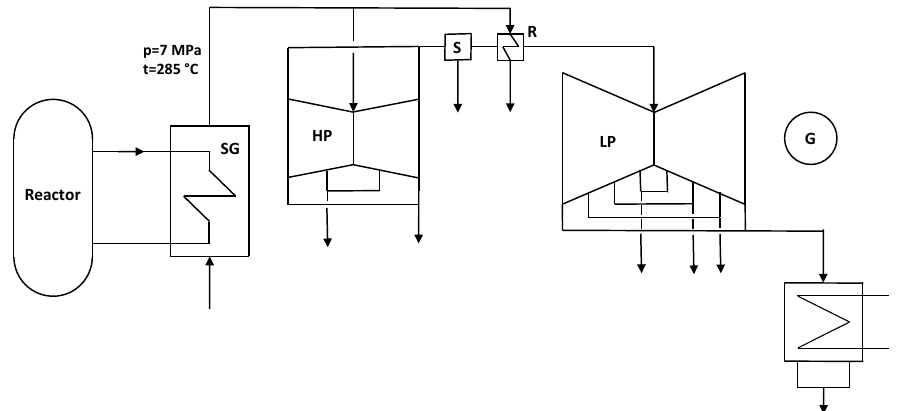
Figure 1. Turbine diagram for a nuclear power plant (SG—steam generator, HP—high-pressure section of a turbine, LP—low-pressure section of a turbine, S—moisture separator, R—reheater, G—generator).